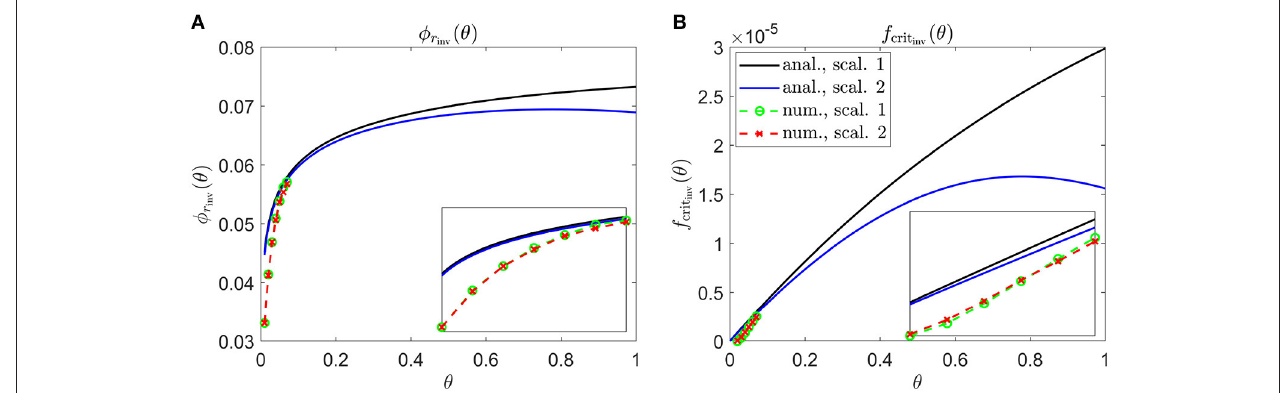
FIGURE 6 | Inverse mutation-induced rod degeneration rate and TF threshold concentration—Uniform target cone degeneration profile. (A) inverse mutation-induced rod degeneration rate, φ r ( θ ) ( f crit = 3 × 10 − 5 ); (B) inverse TF threshold concentration, f crit ( θ ) ( φ r = 7.33 × 10 − 2 ). The solid black and dashed green curves inv inv correspond to Scaling 1 ( α = 7.01 × 10 4 and β = 1.79 × 10 6 ), while the solid blue and dashed red curves correspond to Scaling 2 ( α = 7.01 × 10 2 and β = 1.79 × 10 4 ). The black and blue solid curves are analytical approximations to the inverses, obtained by plotting Equations (7) and (10), respectively (A) , and Equations (8) and (11) respectively (B) . The green and red dashed curves are numerical inverses, obtained by using the Matlab routines fminsearch (A) and patternsearch (B) to calculate the φ r and f crit profiles for which the contour described by p c ( θ , t ) / ˜ p c ( θ ) = 0.99 matches the target cone degeneration profile, t degen ( θ ). Equations (1–5) were solved at each iteration using the method of lines, with 101 mesh points. Insets show magnified portions of each graph. Numerical inverses are calculated and plotted only at those locations (eccentricities) where the analytical inverse fails to generate a t degen ( θ ) profile matching the target profile. Inverses are monotone increasing for Scaling 1, and increase initially for Scaling 2 before reaching a maximum and decreasing toward the ora serrata ( θ = 1). Numerical solutions reveal lower values of the inverses near the fovea ( θ = 0) than the analytical approximations suggest. Cone degeneration profile formulas and parameters are given in Table 3 . Remaining parameter values as in Table 2